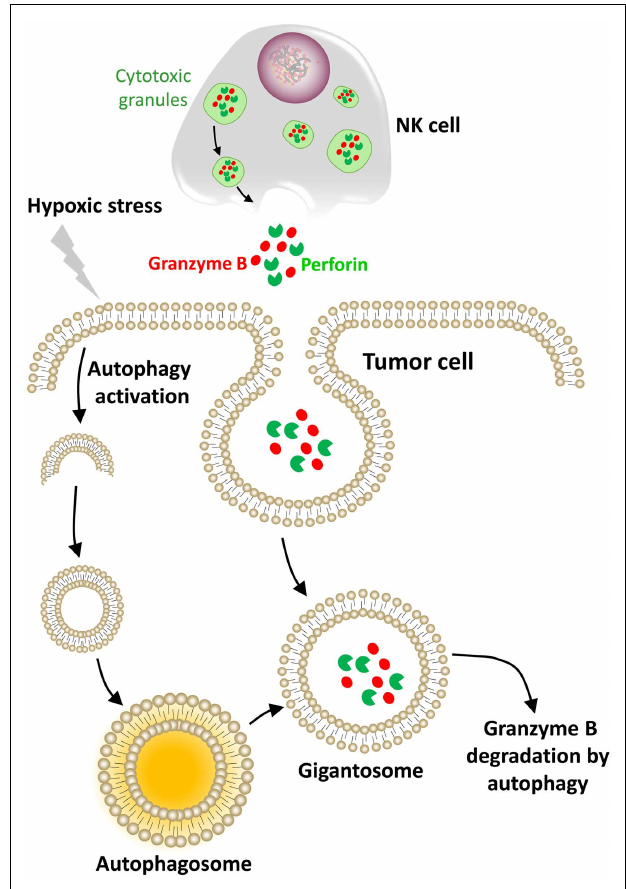
FIGURE 4 | Hypoxic stress activates autophagy in tumor cells as an intrinsic resistance mechanism to NK-mediated killing . In our model, the cytolytic effectors perforin and granzyme B enter the target cells by endocytosis and then are found in enlarged endosomes called “gigantosomes.” In hypoxic cells, the activation of autophagy leads to the formation of autophagosomes that fuse with “gigantosomes” to form amphisomes.The fusion between amphisomes and lysosomes selectively degrades granzyme B in this compartment, making hypoxic tumor cells less sensitive to NK-mediated lysis.